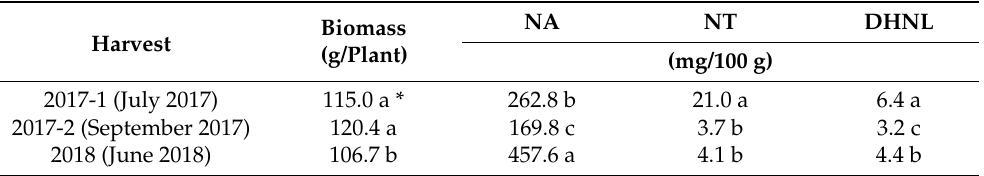
Table 3. Average biomass yield and nepetalic acid (NA), nepetalactam (NT) and dihydronepetalactone (DHNL) content of catnip genotypes content in each